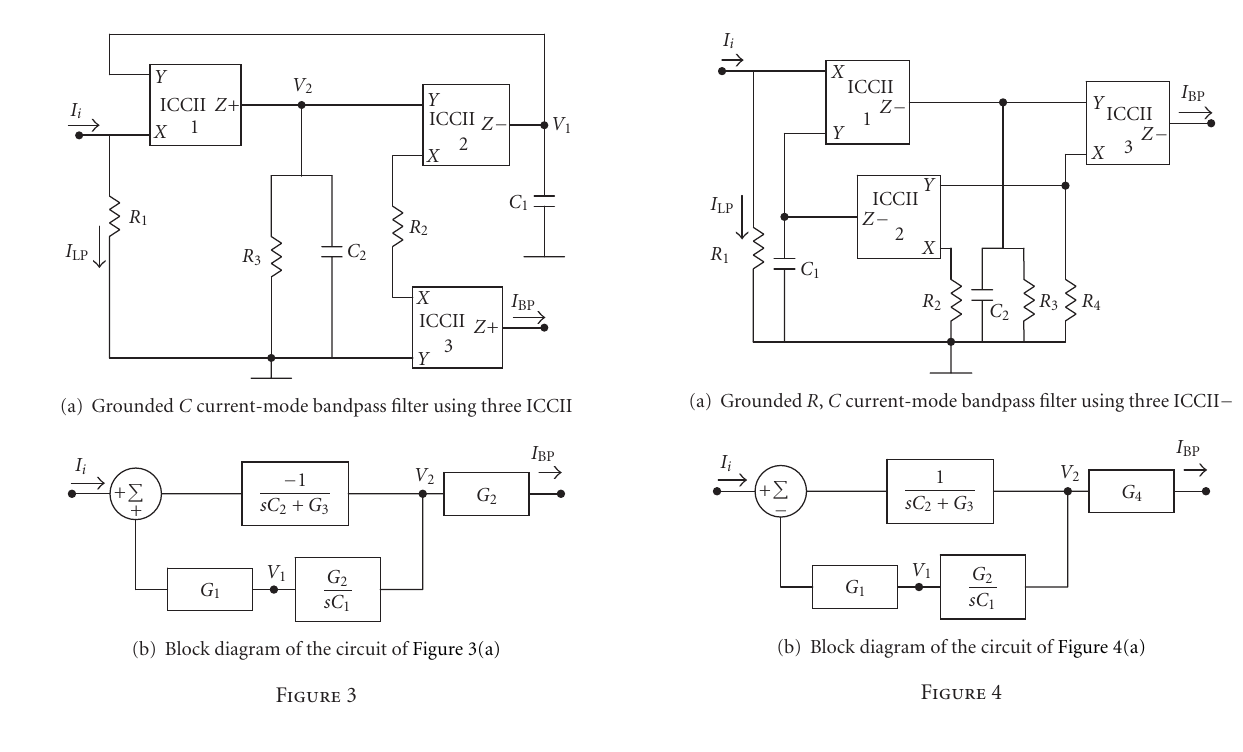
10 pF, R 1 = R 2 = 1.59 k Ω , and R 3 = R 4 = 15.92 k Ω